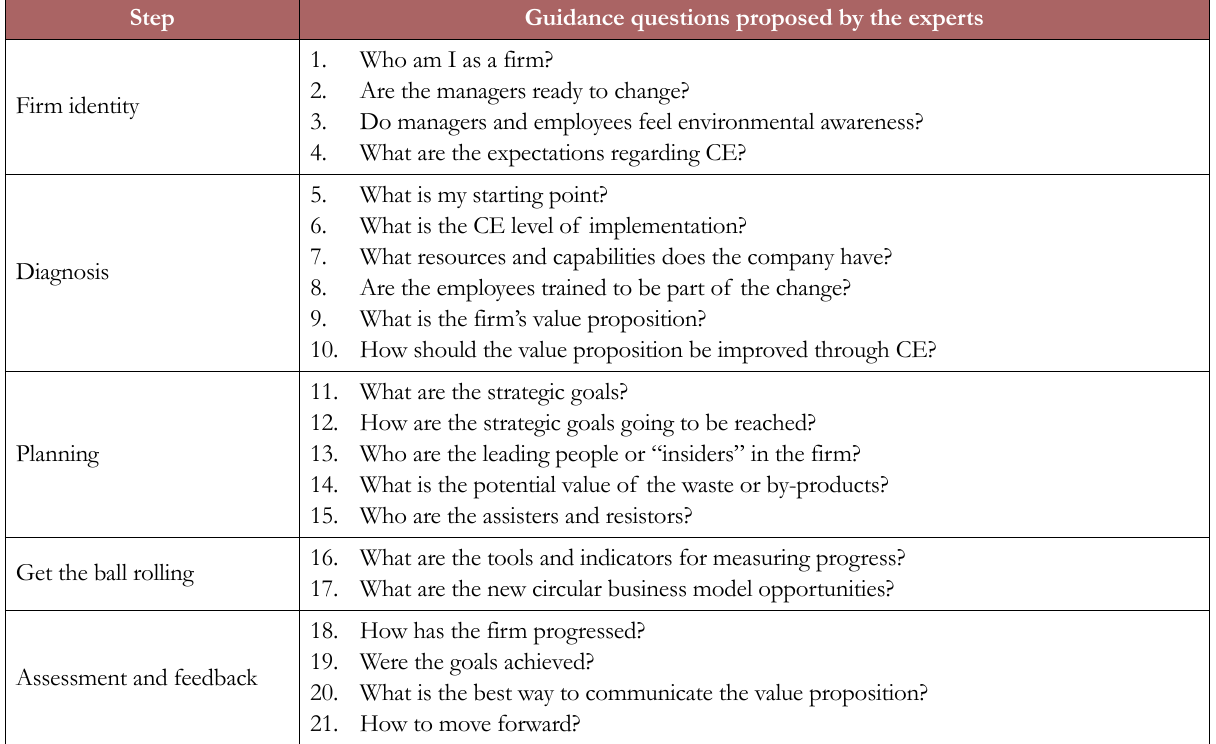
Table 2. Questions that companies must answer for implementing the circular